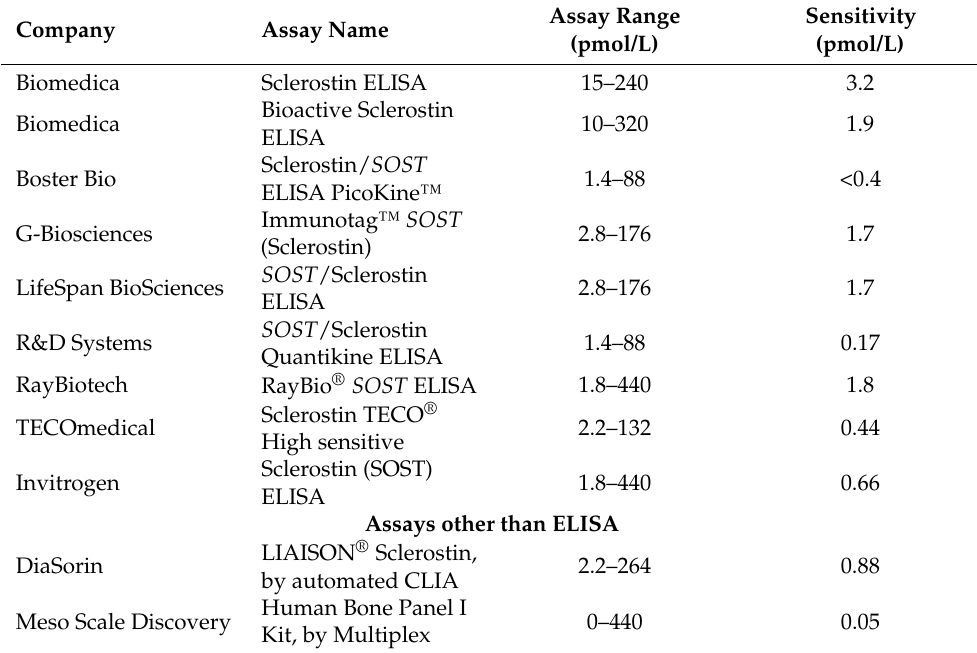
Table 1. Commercially available assays for determination of circulating human